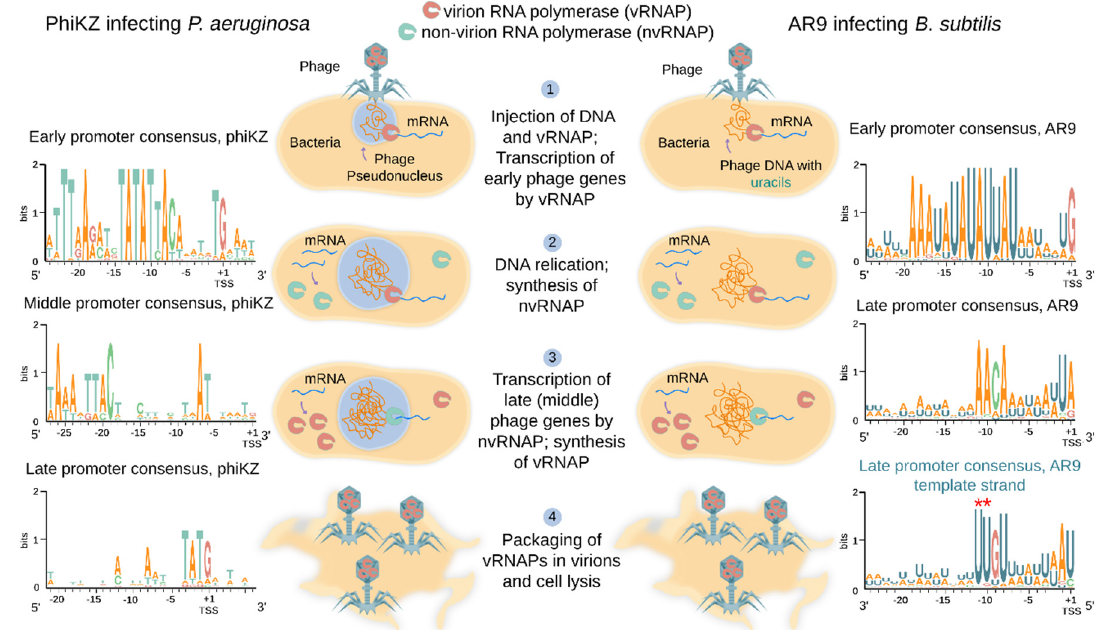
Figure 2. Transcription strategies of jumbo phages encoding two RNAPs. PhiKZ ( left ) and AR9 ( right ) phages are, respectively, representatives of thymine-containing DNA genome phages encoding a pseudo-nucleus, and uracil-containing DNA genome phages that do not encode a pseudo-nucleus. The principal steps of the infection cycle are listed in the middle of the figure. WebLogos of phiKZ early, middle, and late promoters are shown on the left. WebLogos of AR9 early and late promoters are shown on the right. Experimentally identified transcription start sites (TSSs) are marked. For the AR9 late promoter, a WebLogo of the template strand is shown in the right bottom corner. The two uracils crucial for promoter recognition are marked by red asterisks (see explanation in Section 6).